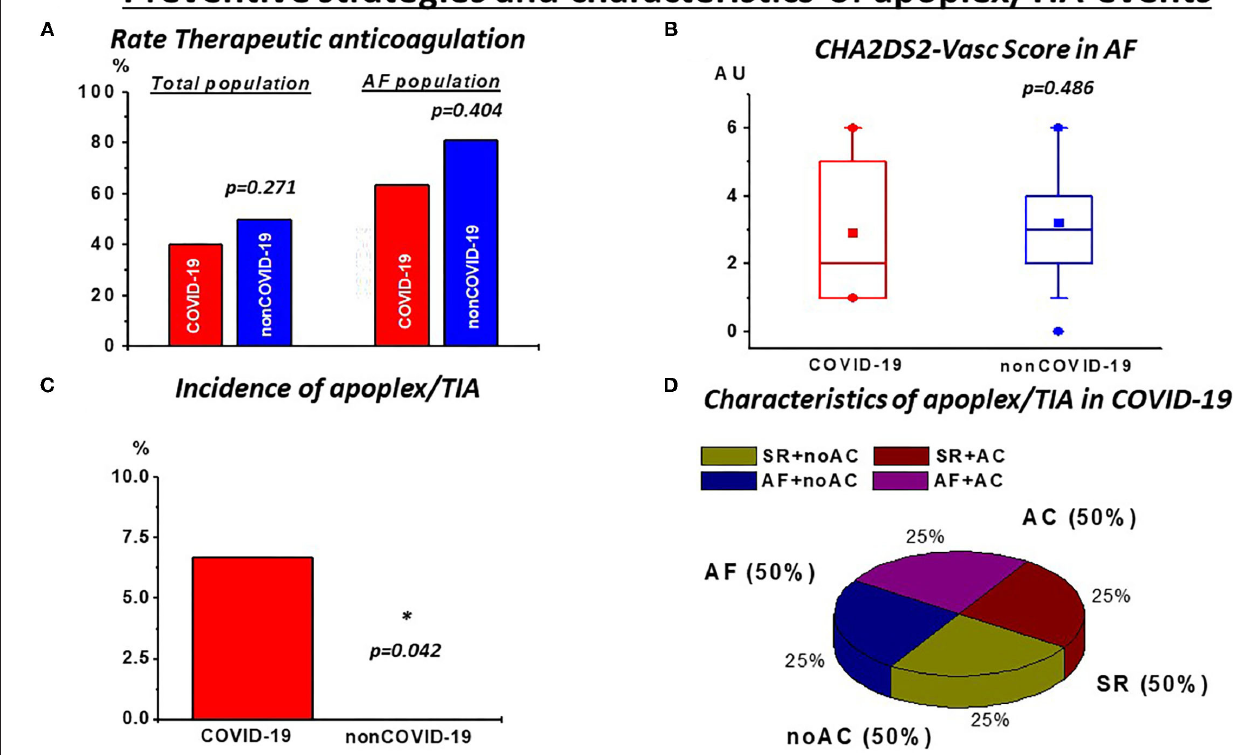
FIGURE 2 | Preventive strategies and characteristics of stroke/TIA events: (A) despite high but not different rates of therapeutic anticoagulation (TAC) in the total population and in patients with atrial fibrillation (AF) during rhythm monitoring as well as (B) similar CHA2DS2-Vasc Scores in this subgroup, (C) incidence of stroke/TIA events was significantly higher in COVID-19. (D) These events were also observed with AC (50%) and with continuous sinus rhythm (SR; 50%) during rhythm monitoring. noAC, no application of TAC. * p <